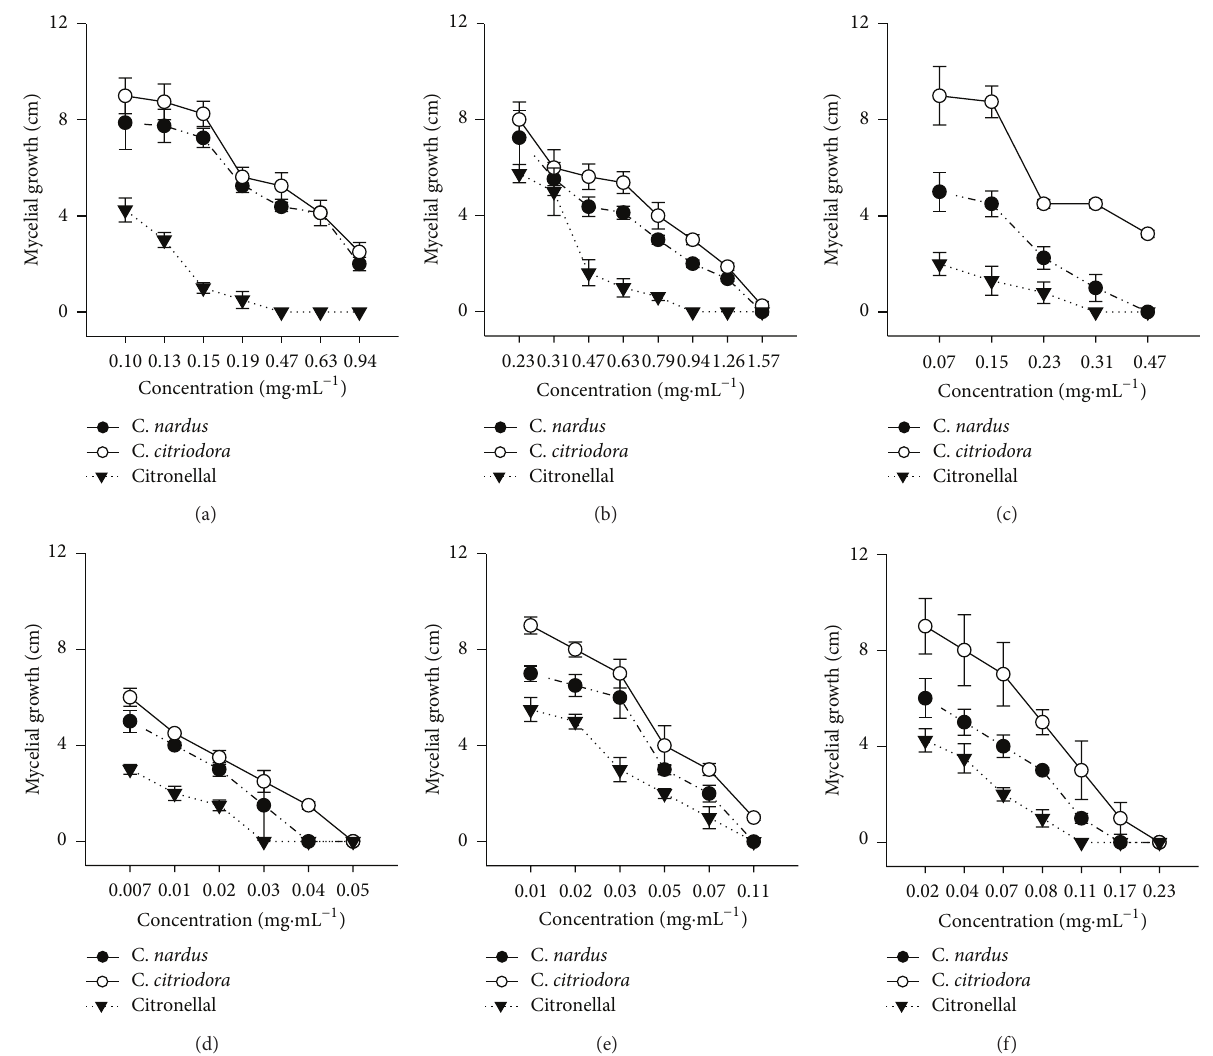
Figure 1: Effects of essential oils of C. nardus , C. citriodora , and the major constituent citronellal in PDA on the mycelial development of P. grisea (a), Aspergillus spp. (b), and C. musae (c). Volatile effects of C. nardus , C. citriodora, and citronellal on mycelial development of P. grisea (d), Aspergillus spp. (e), and C. musae (f), 14 days after